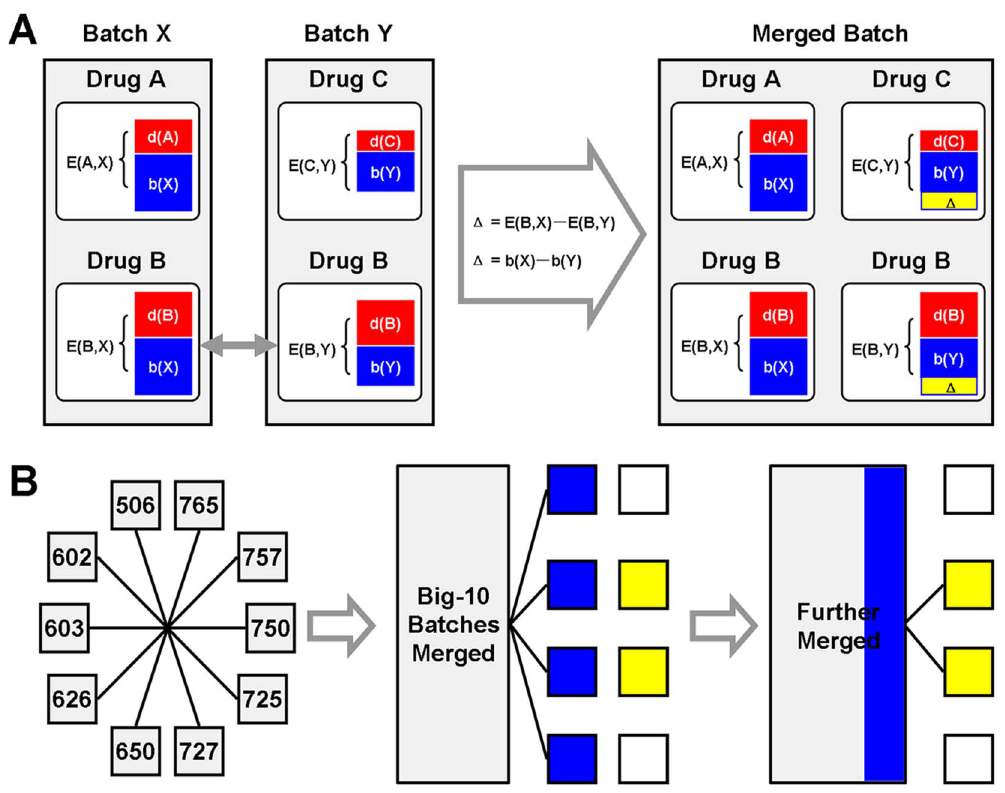
Figure 2. The rationale of batch effect adjustment. (A) The expression profile (denoted as variable E) in CMap is mainly determined by drug action (component d) and batch effect (component b). While the cell condition may vary from batch to batch, the drug action is relatively consistent. Thus, if batch X and Y include cell cultures treated by the same drug (e.g. drug B), these two drug B related expression profiles reflect homogenous drug action but heterogeneous cell condition. So their difference (denoted as D ) reflects the variation between batch X and Y. By adding D to expression profiles in batch Y, the batch variation is adjusted and the two batches are merged into one. (B) Among the batches with 30 instances or more, we find 10 of them linking to each other by various bridge drugs. Primarily, we merged these 10 batches into a new one. Then other batches sharing bridge drugs with this new batch are further merged to form an even bigger batch. This bridging procedure is repeated until all batches are